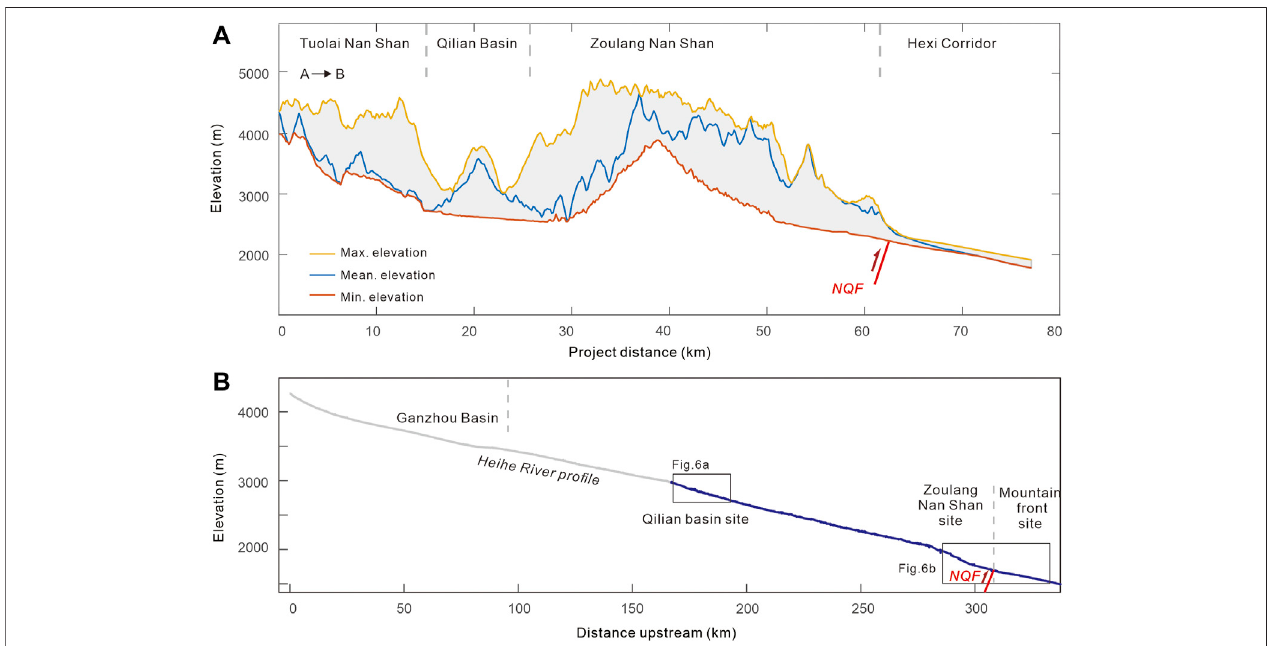
FIGURE 2 | (A) Swath pro fi le (10 km × 10 km) across the Tuolai Nan Shan-Hexi Corridor. (B) Longitudinal pro fi le of the Heihe River. Terraces along the blue reach aredividedintothreesegments:Qilianbasinsite,ZoulangNanShansite,andmountainfrontsite.Locationsoftheswathpro fi leandthebluereachareshownin Figure1 . NQF, North Qilian Shan